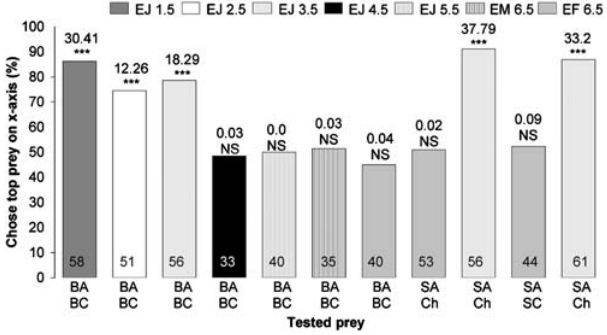
Figure 3. Simultaneous-presentation mount tests of fasted Evarcha culicivora. Percentage: spiders that chose prey type at top list of two under bar. E= Evarcha culicivora . J=juvenile. F=adult female. M=male. BA=blood-fed Anopheles . SA=sugar-fed Anopheles . BC=blood-fed Culex . Ch=chironomid midge. Spider body length in mm. N inside each bar. Tests of goodness of fit: chi-square statistic above bar; null hypothesis, 50/50; *** P , 0.001.